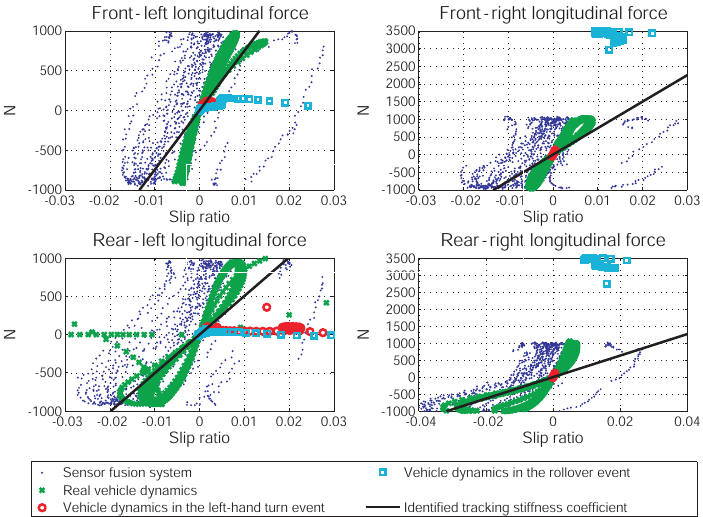
Figure 10. The relations between the slip ratio and the longitudinal tire adhesive force.